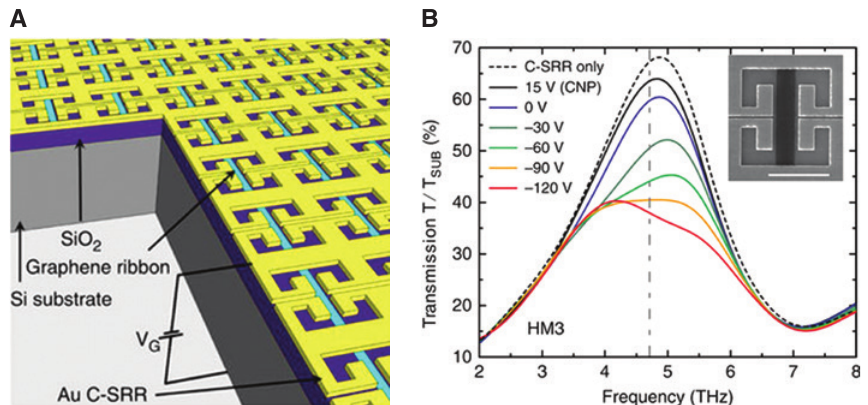
Figure 10: (A) Schematic design of the hybrid graphene C-SRR device. The graphene ribbons are positioned in the center of the C-SRR to maximize the coupling between the two resonances. (B) Modulation depth performance; it is possible to observe the anti-crossing between the two resonances for different biases of the graphene. Reprinted and adapted from Liu et al.